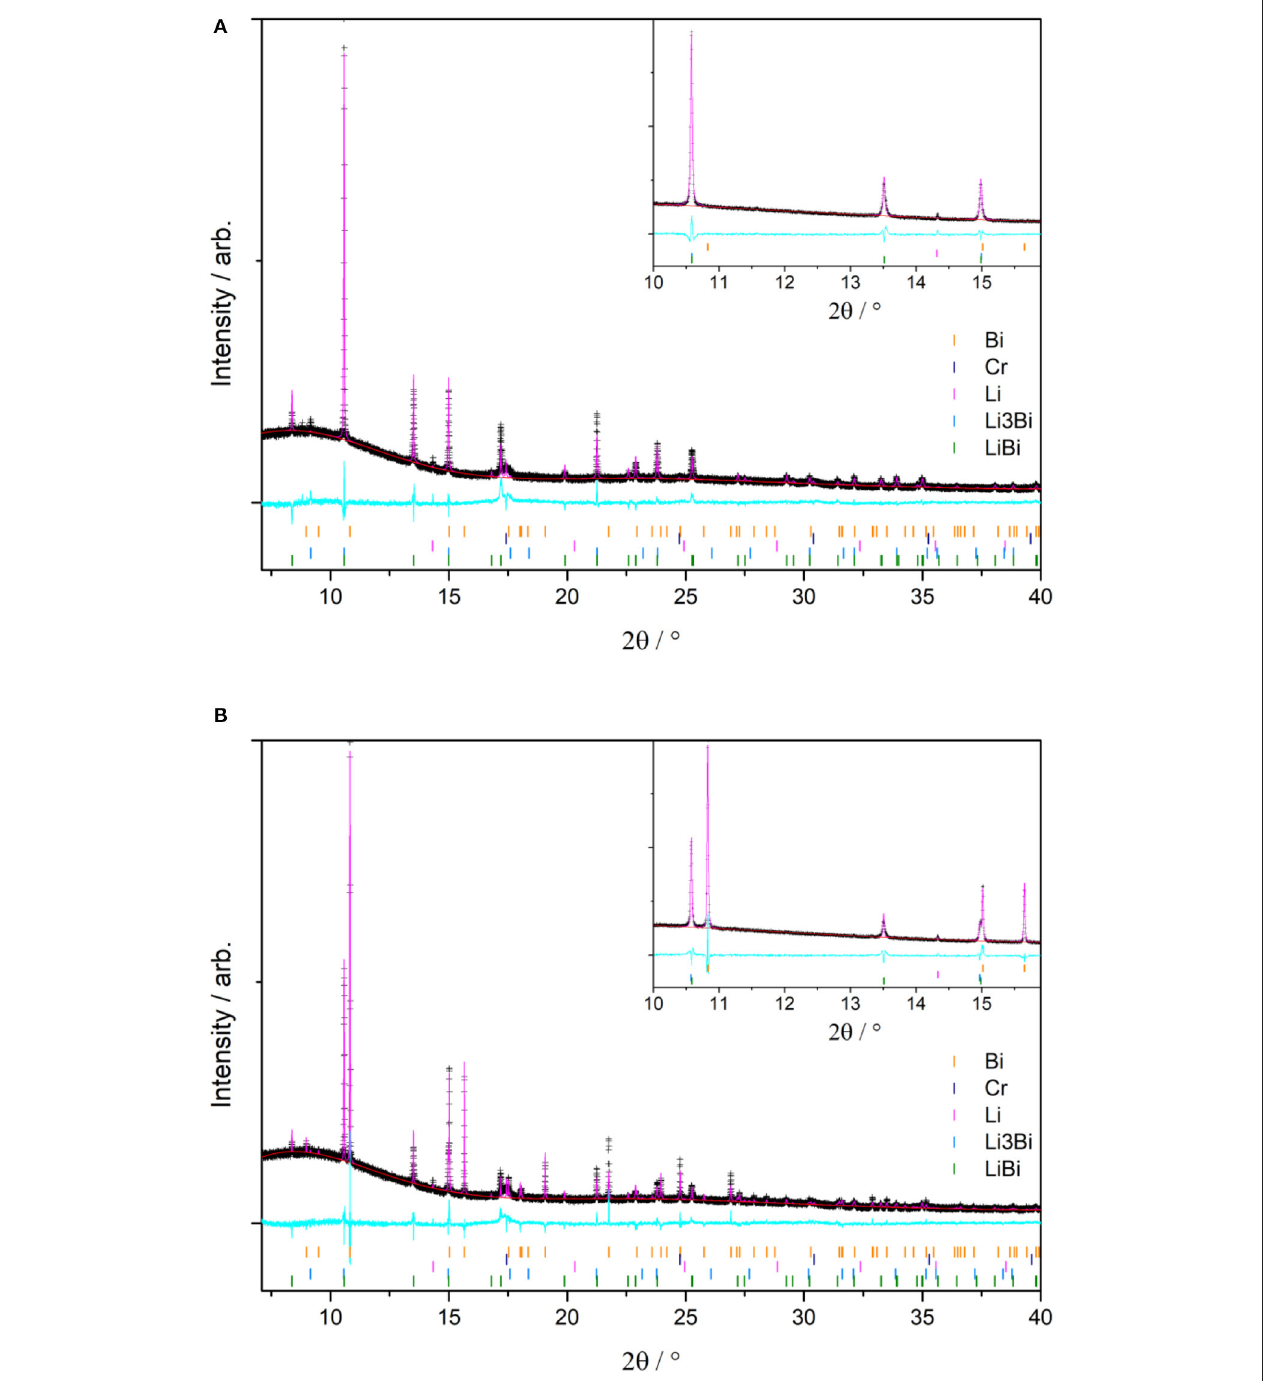
FIGURE 2 | Rietveld refinement profile of the (A) first dataset (discharged state) and (B) the last dataset (charged state). Reflections from all three major phases are present in the last dataset. Observed data are represented as crosses ( + ), calculated model as pink line, background function as red line, and difference as cyan line